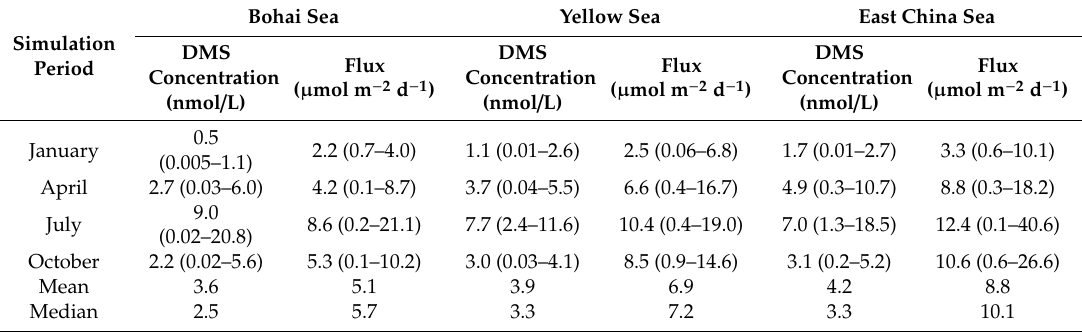
Table 2. Seasonal variation of DMS emission flux in di ff erent sea areas. (The value outside the parenthesis represents the mean and the ranges inside the parenthesis represent the minimum and maximum,